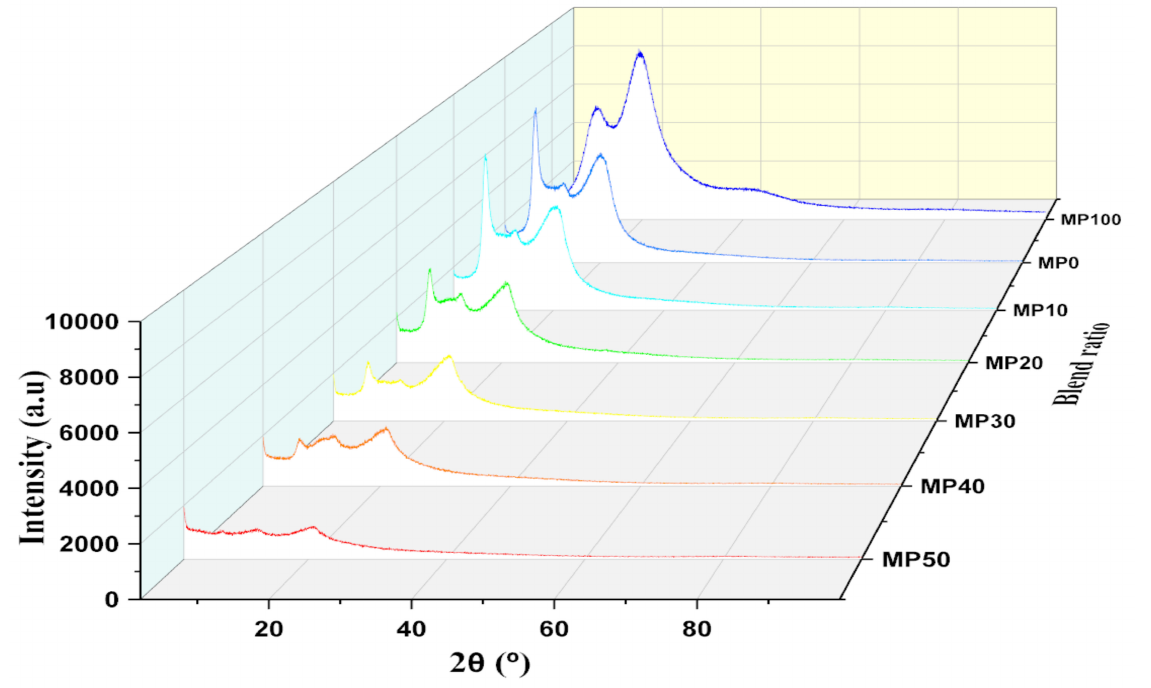
Figure 6. XRD pattern of the MC/PVP polymer